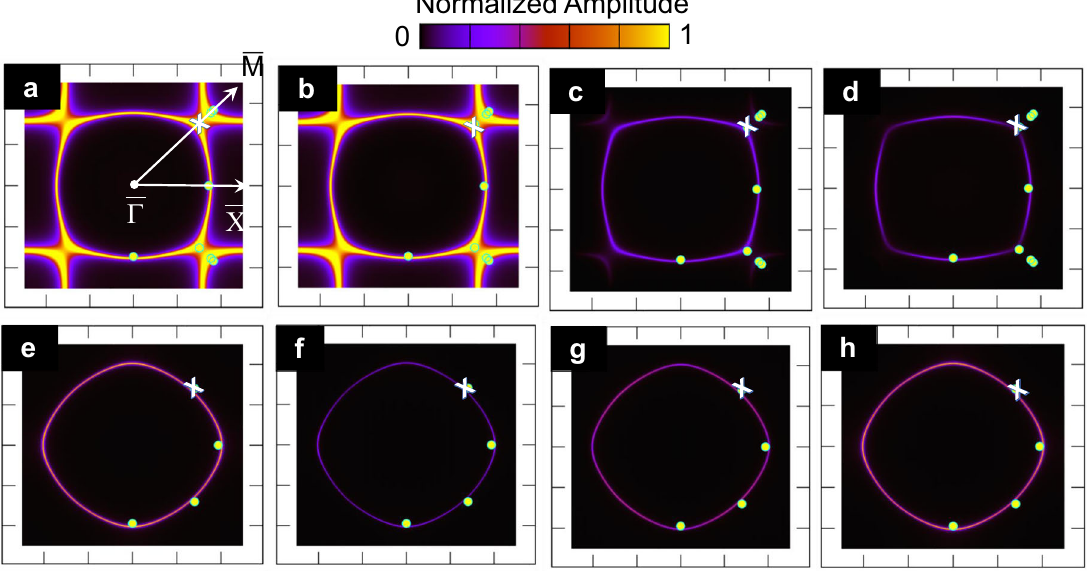
Fig. 5 Two-dimensional momentum space distribution of magnons in the Co/Co/Fe system. The energy cuts are chosen so as to highlight the in-plane wavevector of 1 Å − 1 along the high symmetry (cid:1) Γ – (cid:1) M ( (cid:1) Γ and (cid:1) M represent the high symmetry points of the surface Brillouin zone). Panels a – d show the results for the magnon energy of 66 meV (magnons with n = 0) and e – h are the results for the magnon energy of 180 meV (magnons with n = 1). The total Bloch spectral function is shown in panels ( a , e ). The Bloch spectral function projected into the interface ( b , f ), middle ( c , g ), and surface layer ( d , h ) is also